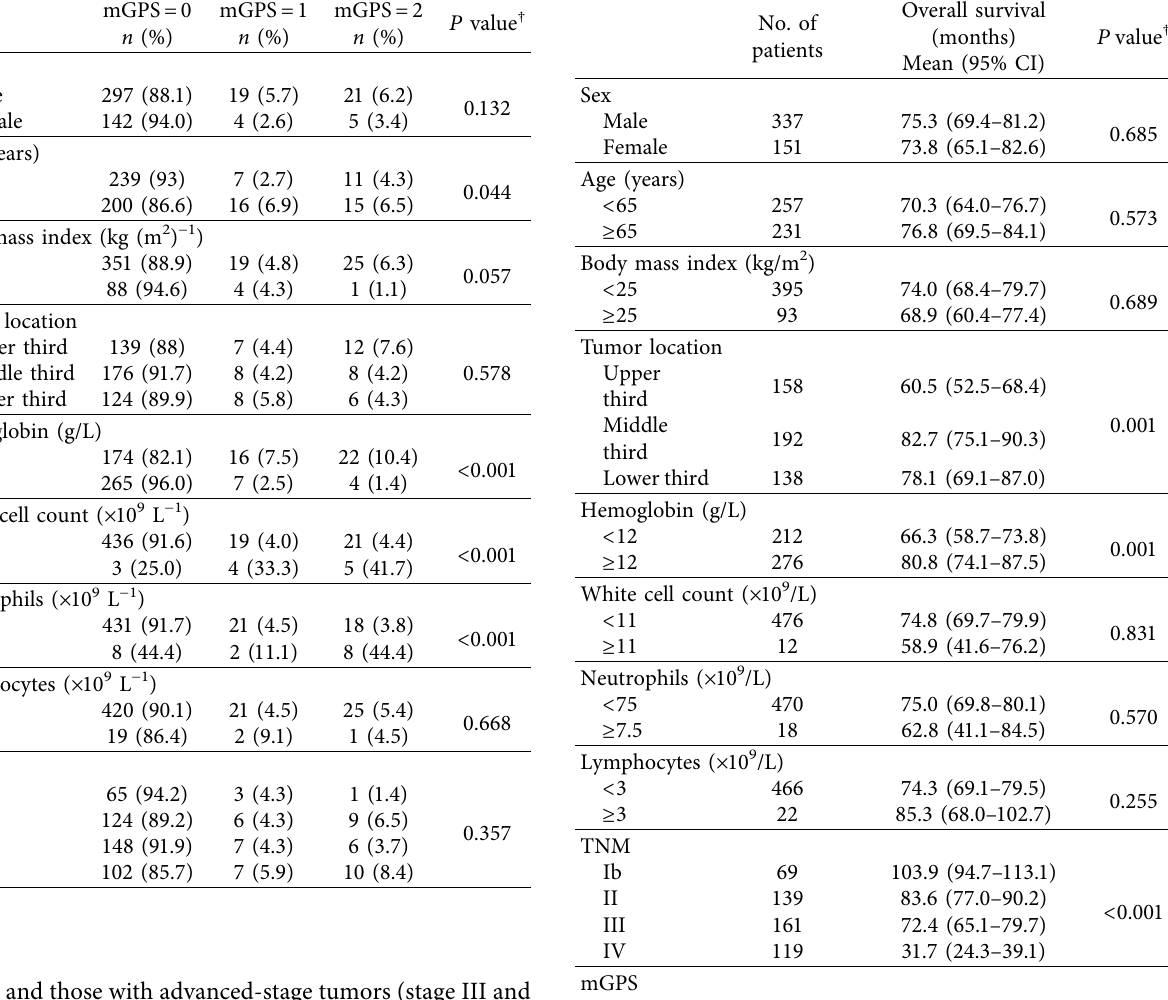
Table 2: Clinical and laboratory characteristics associated with overall survival.